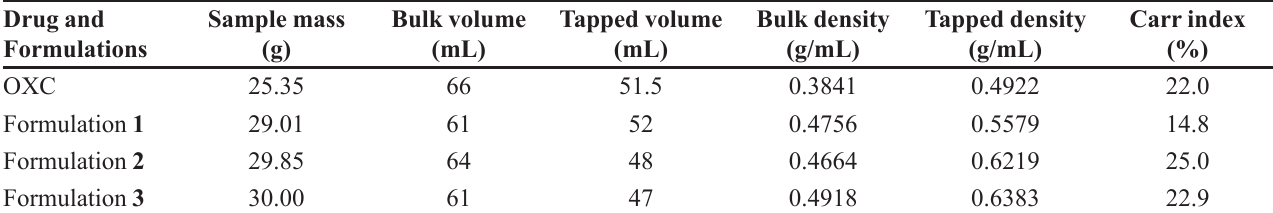
Table IV - Results of density measurements Drug and Formulations